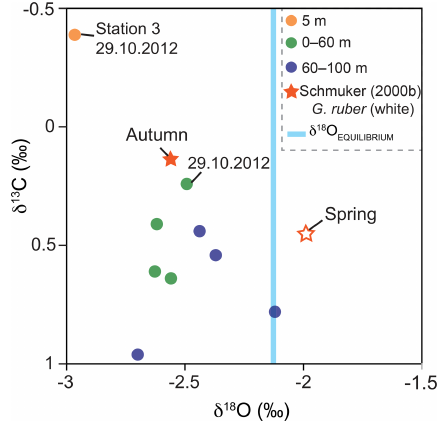
Figure 8. Stable oxygen and carbon isotope values of G. ruber (pink) and average δ 18 O EQUILIBRIUM value of ambient surface water. Green and blue dots indicate the average values of sta- tions 1 and 2 from the four sampling days and two sampling depth intervals in 2012 (this study). Stars indicate the isotope data of Schmuker (2000b) from G. ruber (white) collected in autumn 1994 and spring 1995. Orange dot: stable isotope value of individuals collected at station 3 on the 29 October 2012 (this study). Note: hurricane Sandy passed the Greater Antilles in late October 2012 resulting in high δ 13 C CALCITE values on 29 October in the mixed